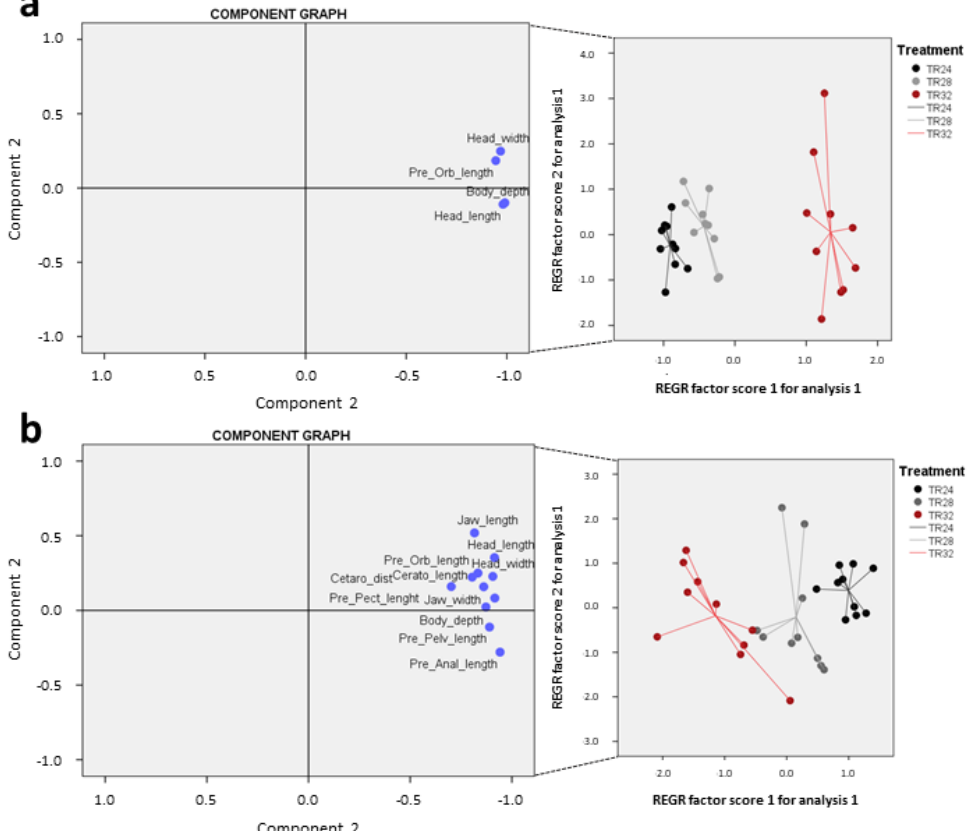
Figure 7. Scatter plot of experimental groups (with centroid distribution of the replicates) separated by the two principal components obtained from a principal component analysis (PCA), to reduce the dimensionality of the dataset, when embryos of A. tropicus were incubated at different thermal regimens. Representation is according to normalized biometric data at hatching ( a ) and 16 days post-fertilization (dpf) ( b ).